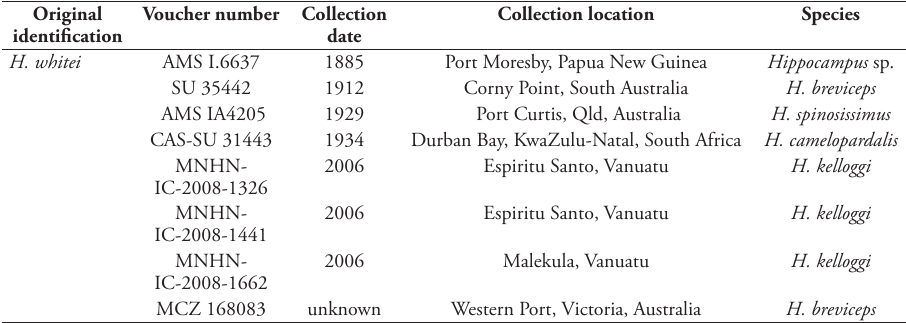
Table 6. List of seahorse specimens originally identified as H. whitei , including voucher number, collec- tion date, collection location, and